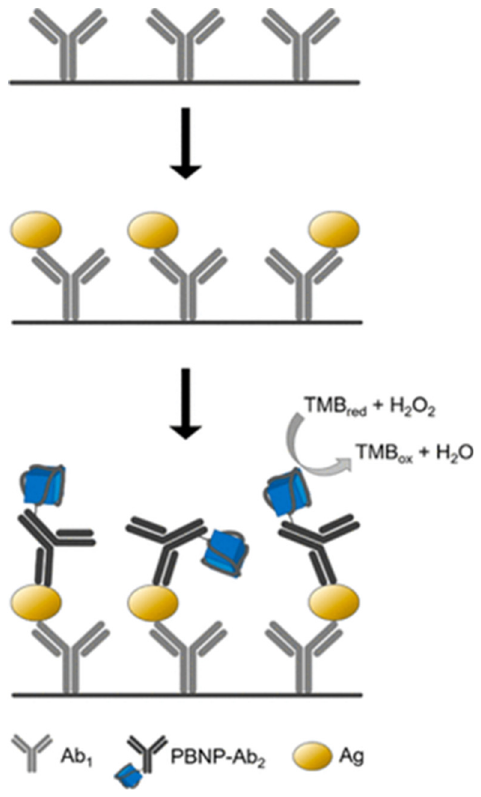
Figure 3. Scheme of PBNPs-based sandwich NLISA. The microtiter plate is coated by capture antibody (Ab 1 ), followed by specific binding of antigen (Ag) and formation of sandwich with the detection PBNPs-Ab 2 label. The colorimetric readout is based on PBNPs-catalyzed oxidation of TMB in the presence of H 2 O 2 . Reproduced with permission from [30].